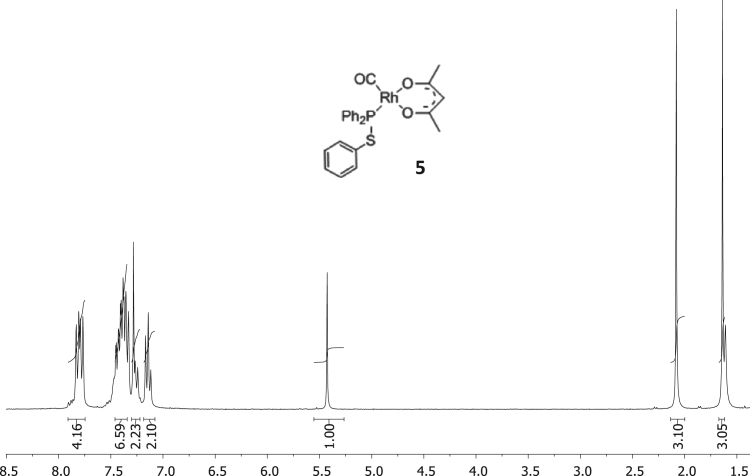
1H NMR of [Rh(acac)CO(C6H4SPPh2)], 5.